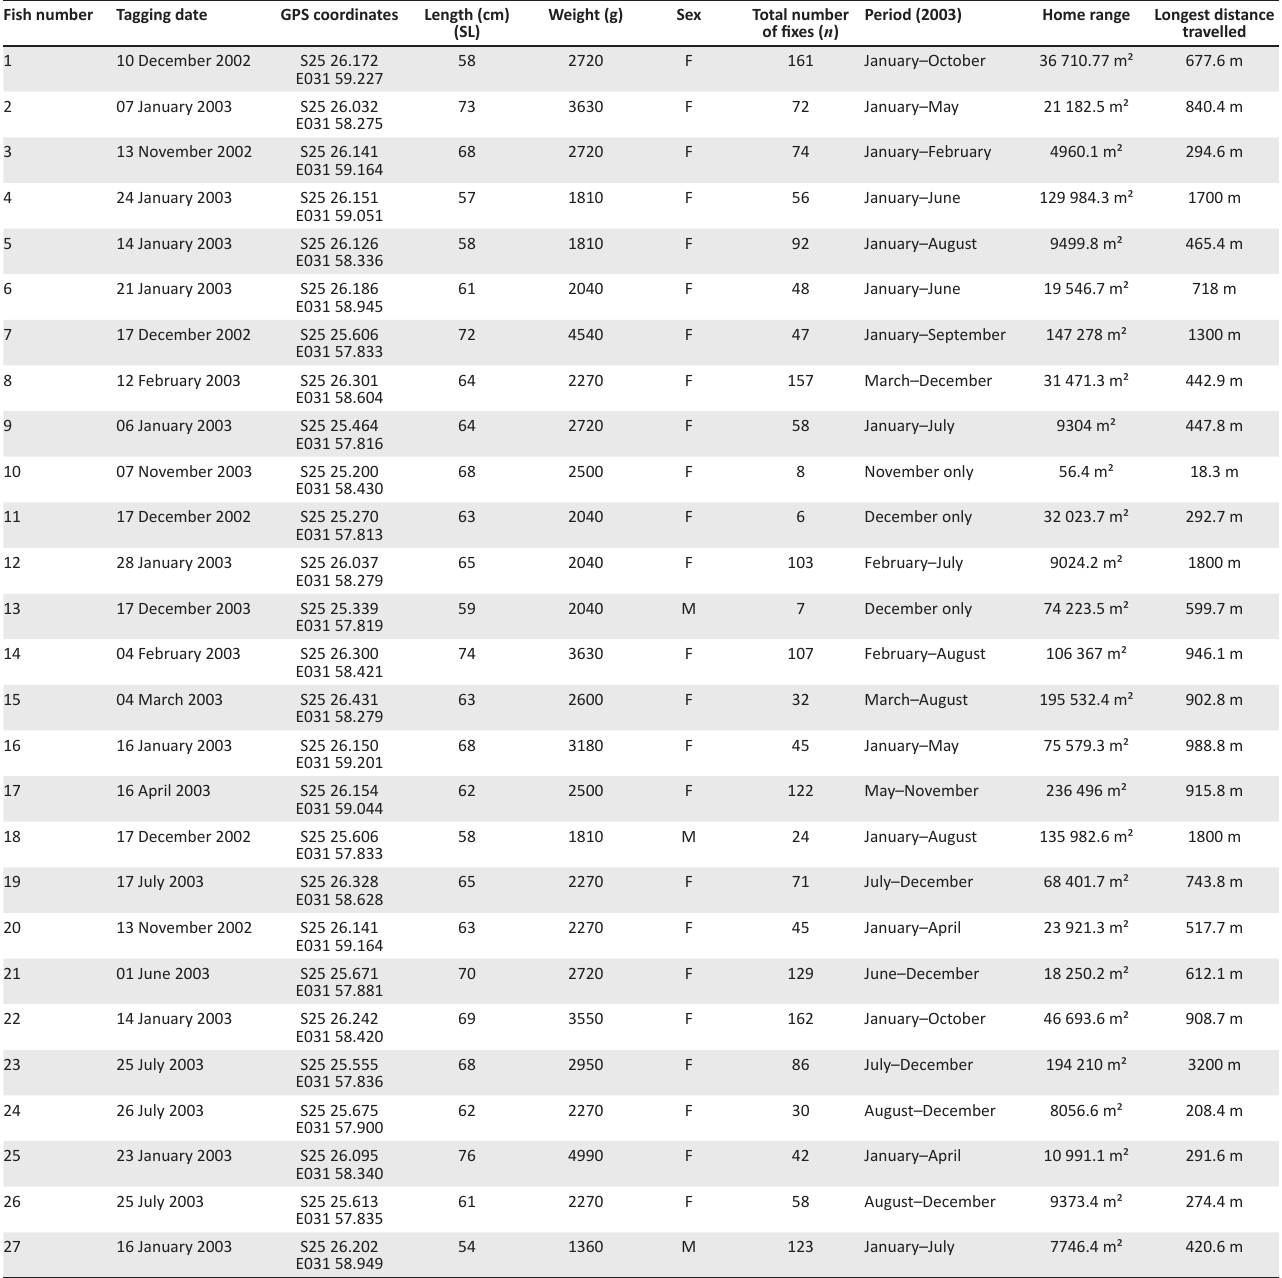
TABLE 1: Individual fish collection, release and radio-tagging data (home range and longest